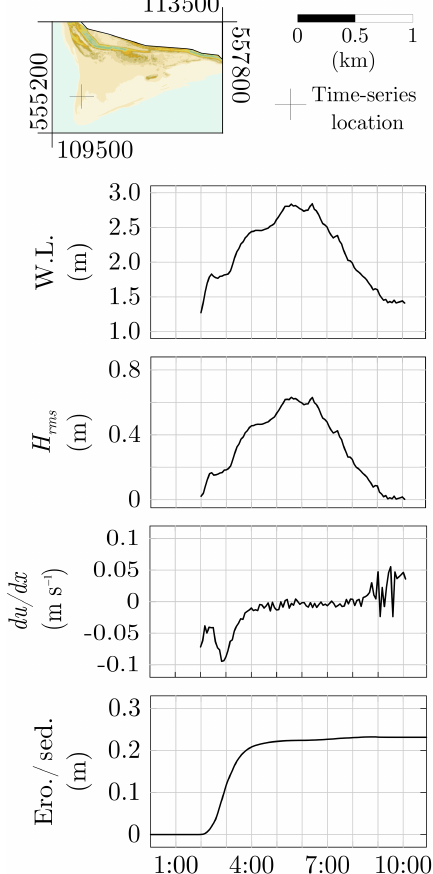
Figure 12. Time series of hydrodynamic and morphological char- acteristics extracted from scenario k.